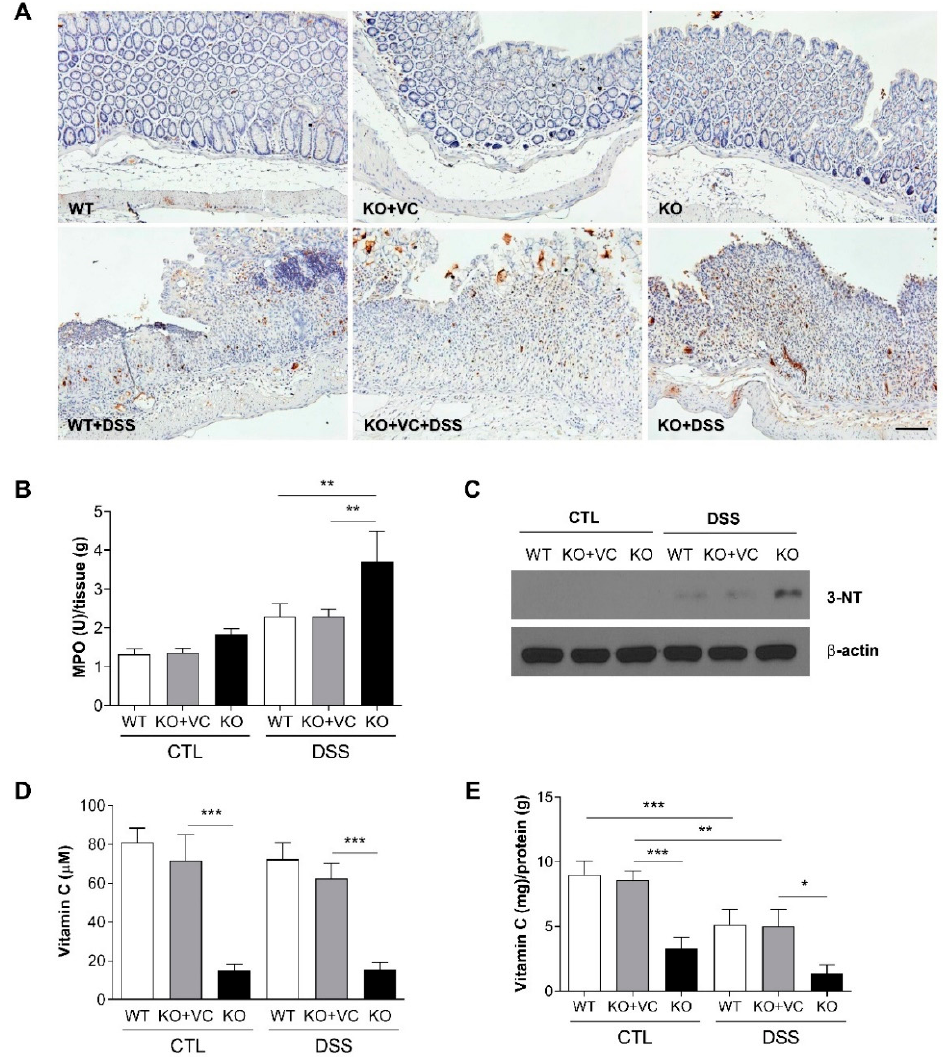
Figure 2. Vitamin C insufficiency and DSS treatment increase inflammation and oxidative stress. WT and KO mice were treated with DSS for 7 days. ( A ) Colons were stained with anti-Gr1. Scale bar, 100 µ m. ( B ) The level of MPO was measured in homogenized colon lysates and normalized to tissue weight. ( n = 15–17). ** p < 0.01. ( C ) The expression of 3-NT was evaluated with immunoblotting. The results are representative of three independent experiments. The concentration of vitamin C in ( D ) plasma ( n = 8–12) and ( E ) colon lysates ( n = 6–8) was measured using an ascorbate assay kit and normalized to colon weight. * p < 0.05, ** p < 0.01, *** p < 0.001. Statistical analysis was performed using the Tukey multiple comparisons test after one-way